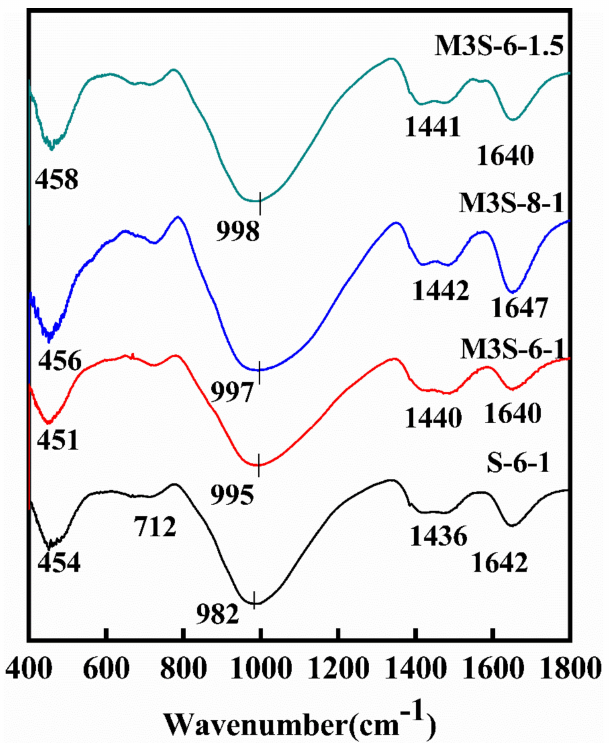
Figure 13. FTIR spectra of alkali-activated slag containing 30% metakaolin with different activator concentrations and